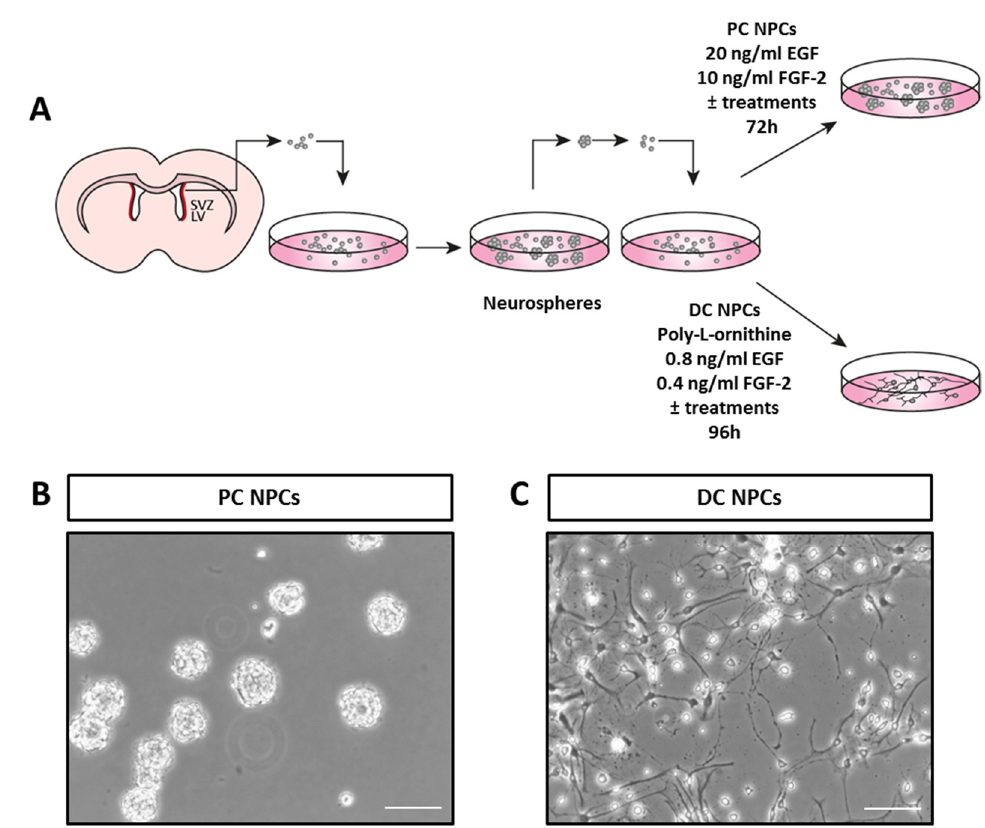
Figure 1. Neural progenitor cells of the postnatal subventricular zone in proliferation and differentiation conditions. ( A ). Schematic drawing of the design of the protocol used in this study. The subventricular zones (SVZ, in red) adjacent to the lateral ventricles (LV) were dissected out from coronal slices obtained from 7-day postnatal rat brains, and neural progenitor cells (NPCs) contained in this region were cultured in the form of neurospheres, as described in Methods. Neurosphere-derived NPCs were exposed to different treatments in proliferation conditions (PC) or in differentiation conditions (DC). ( B ). Phase-contrast photomicrograph showing neurospheres or floating cell aggregates of NPCs in proliferation conditions (PC NPCs) without treatments. ( C ). Phase-contrast photomicrograph showing NPCs grown in differentiation conditions (DC NPCs) without treatments. Bar: 100 µm. EGF (epidermal growth factor), FGF-2 (fibroblast growth factor).